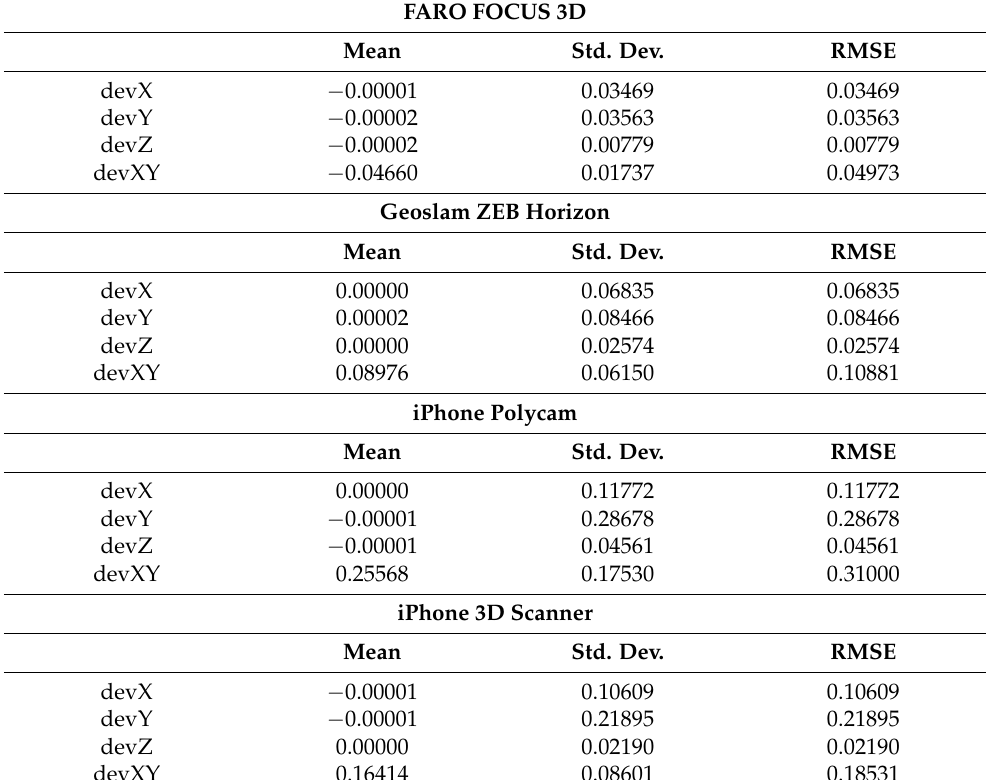
Table 2. Statistical evaluation of positional and height deviations compared to the reference crosses from tacheometric surveying.